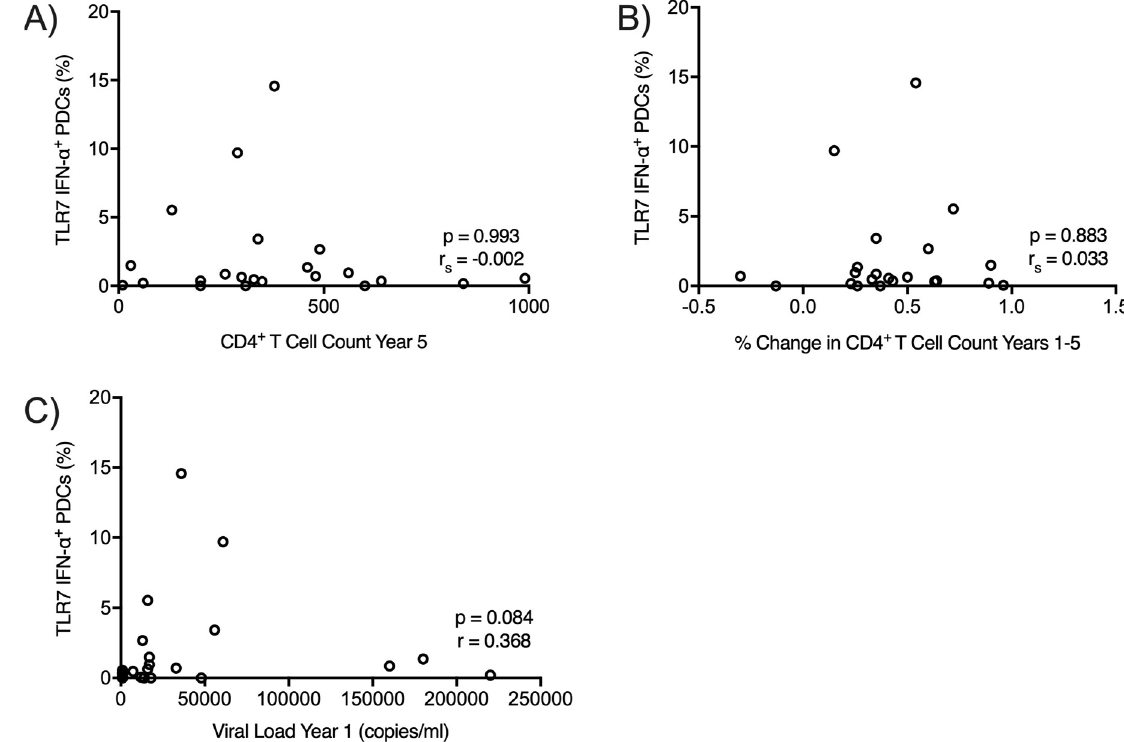
Fig 6. IFN- α production by TLR7 in PDCs does not correlate with CD4 + decline and viral load in the Amsterdam Cohort. PDC TLR7 receptors were stimulated by HIV-1 ADA . IFN- α production by PDCs was correlated with either the number of CD4 + T cells 5 years post- infection, the percent change in the number of CD4 + cells from 1 to 5 years post infection, or the viral load in year 1. P and r s values were calculated by the Spearman rank